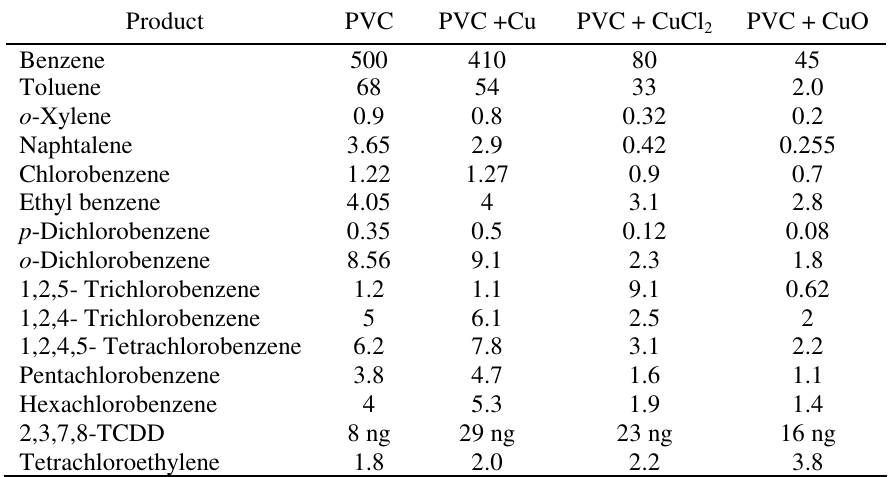
Table 6 . The amount ( µ g) of organic gases products from the combustion of pure PVC and mixtures of PVC in presence of copper, copper(II) chloride and cupric oxide at 600 ° C under